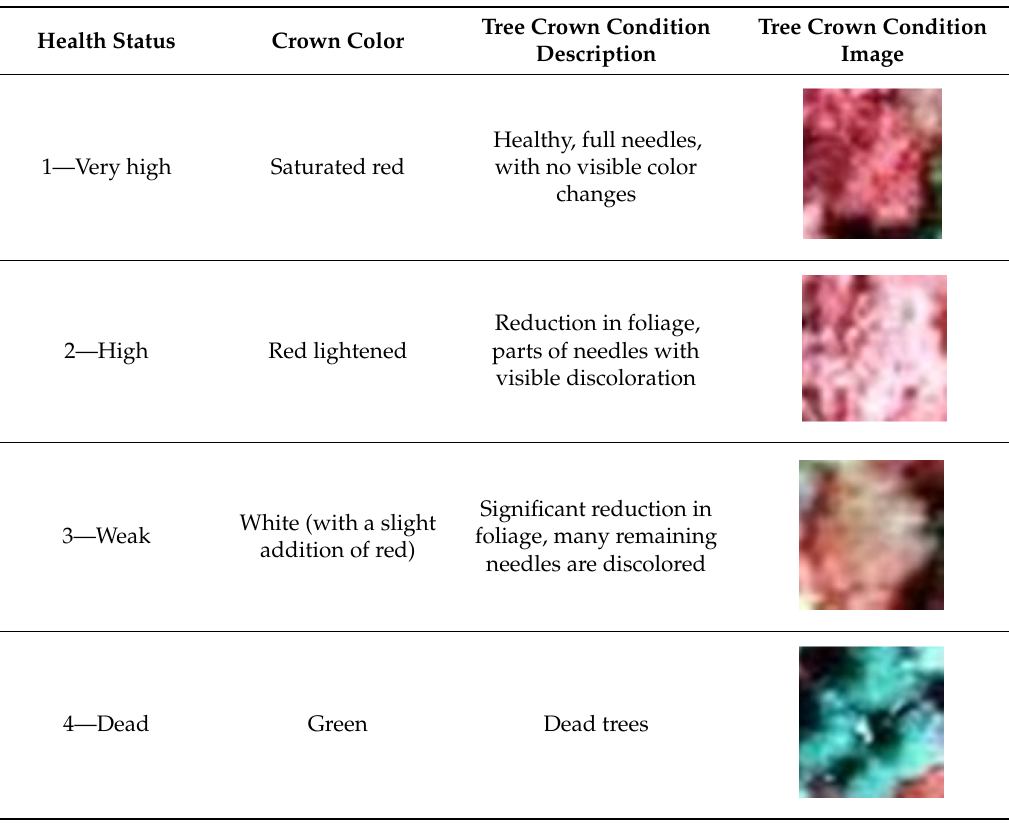
( b ) Figure 2. Health status evaluation from the ground of the same Norway spruce monumental tree. ( a ):high health status (2014); ( b ): dead (2017). Photo by A. Chrenowski.